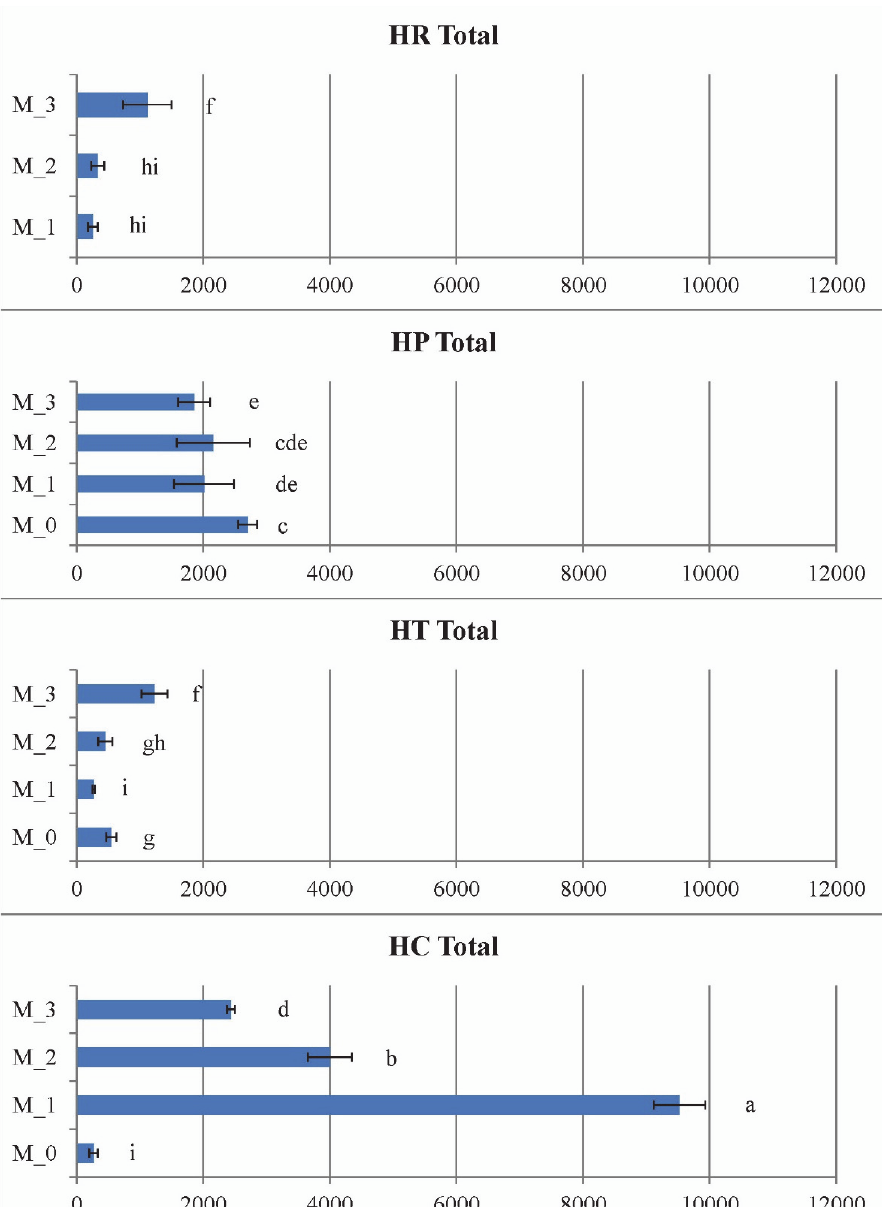
Figure 8. The sum of jasmonic acid (JA) and its bioactive conjugate JA-isoleucine in the four Hypericum species in M_0—PGR-free, M_1—0.2 mg/L BA, M_2—0.2 mg/L BA + 0.1 mg/L IBA and M_3—0.1 mg/L BA + 0.2 mg/L IBA supplemented media. HR– H. richeri Vill., HP– H. perforatum L., HT– H. tetrapterum Fries. and HC– H. calycinum . Same letters indicate statistically